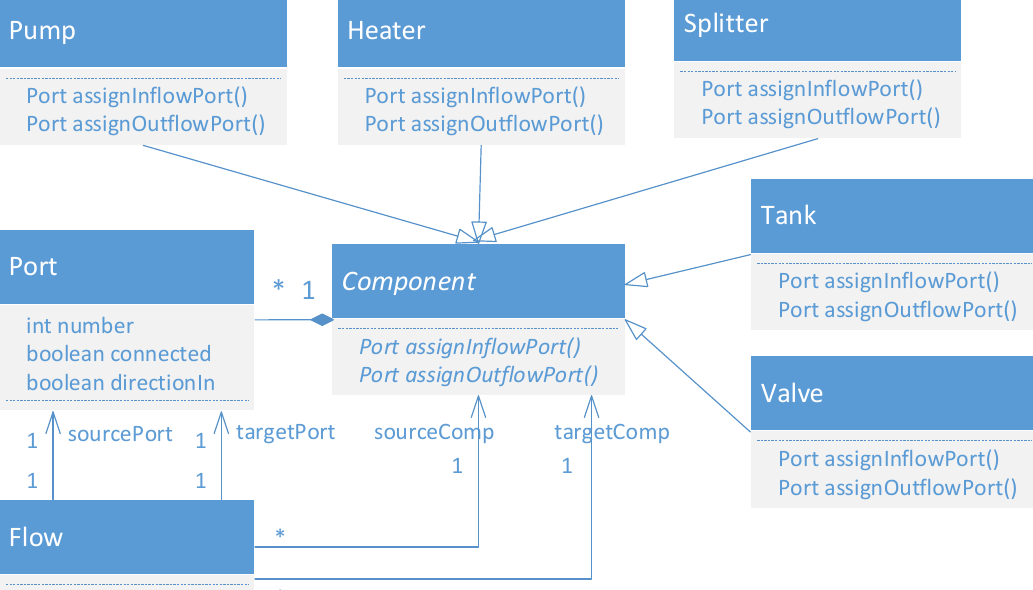
Figure 5. Di ff erent symbols in the Balas ® simulation software for simulating process equipment. Figure 5. Different symbols in the Balas® simulation software for simulating process equipment. Table 1. Rules for a one-to-one mapping from an intermediate graph to a steady state model.